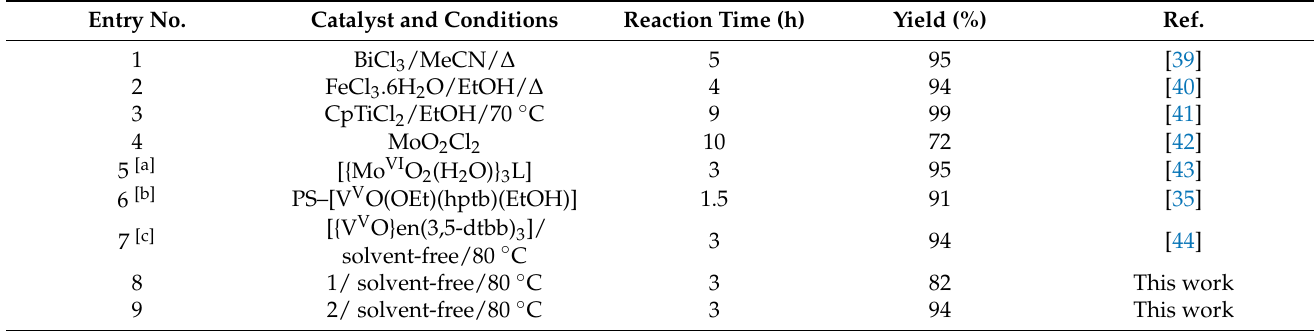
Table 5. Comparison of the results of the synthesis of 3,4-dihydro-5-ethoxycarbonyl-4-(4-phenyl-6- methylpyrimidine-2(1 H )-one using different catalysts.